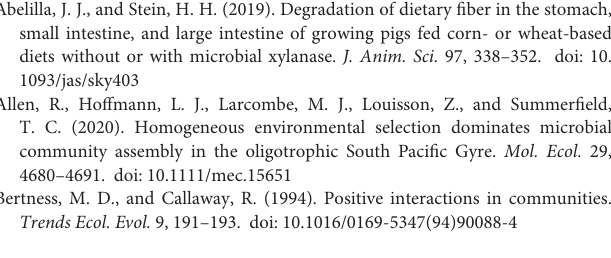
based on Bray-Curtis (A) and Jaccard (B) distances.